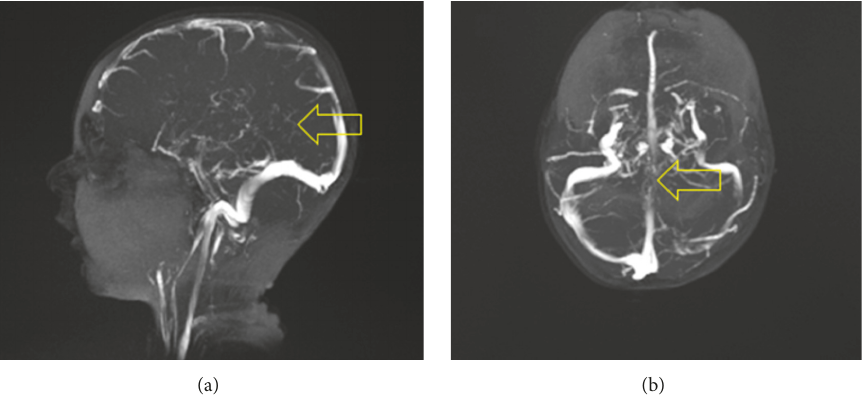
Figure 3: MRV was performed which showed a filling defect of straight sinus and internal cerebral veins (yellow